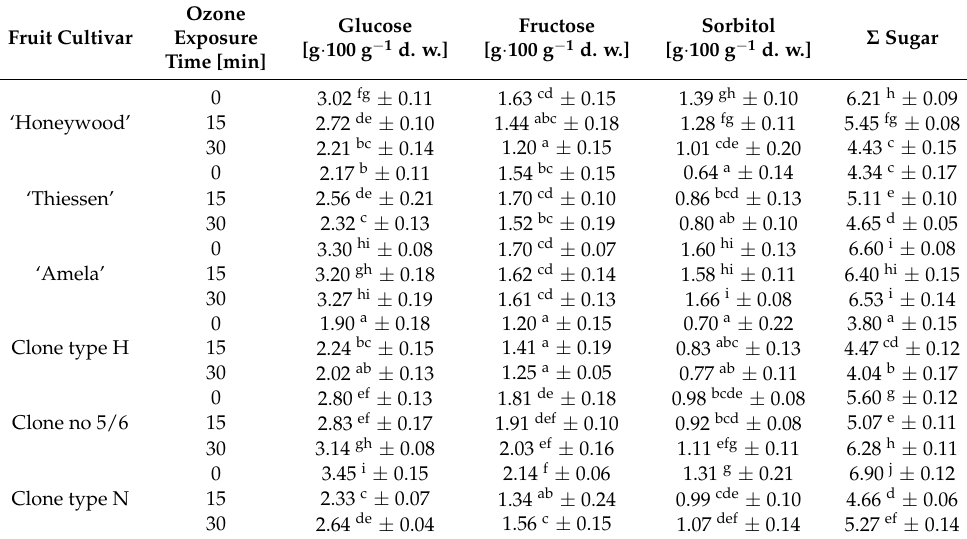
Table 3. The sugar profile of the fruit of the Saskatoon berry. Fruit